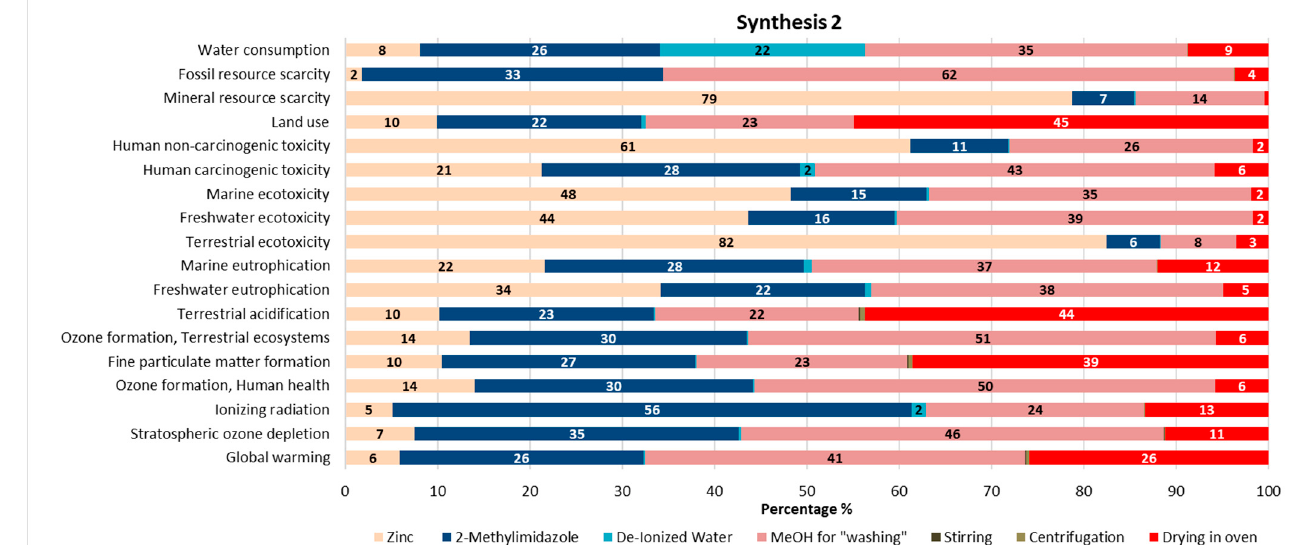
Figure 6. Life Cycle Assessment of the 3rd synthetic approach of ZIF-8. Method: ReCiPe 2016, midpoint (H) V.1.01.